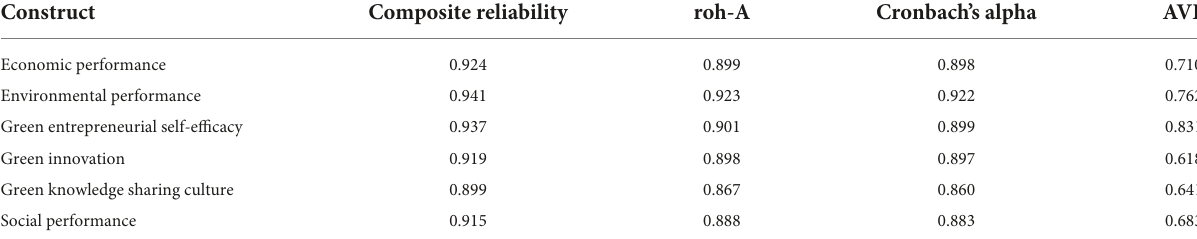
TABLE 1 Measurement reliabilities.